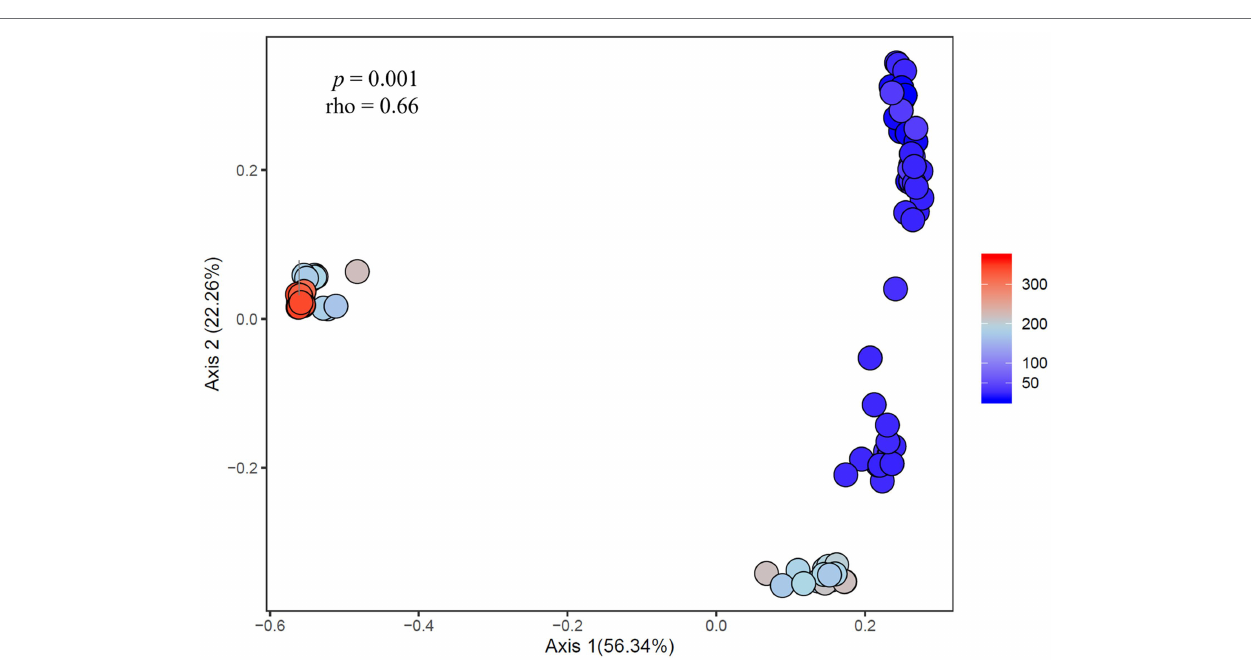
FIGURE 8 | Principal coordinates analysis showing the dissimilarity of heterotrophic bacteria compositions (ASV-derived) between samples correlated to cyanobacteria abundance across experiments. Percent listed on the axes represents the percent variation explained. The color gradient denotes the fluoroprobe- derived cyanobacteria Chl a abundance per sample, with blue indicating lower cyanobacteria abundances and red indicating higher cyanobacteria